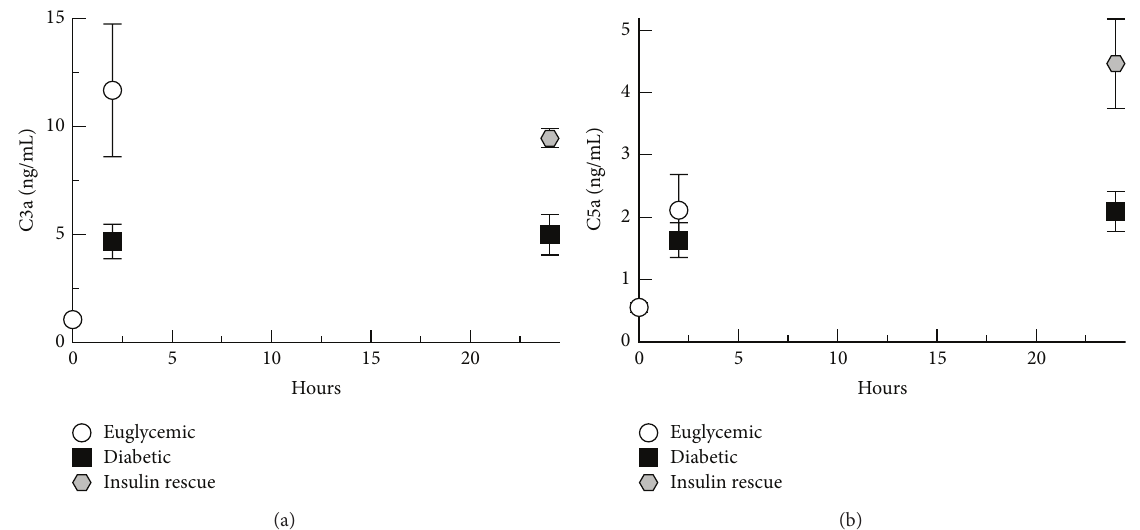
Figure 3: Anaphylatoxin generation in the peritoneum. (a) C3a concentrations in peritoneal wash fluid assayed by quantitative Western blot. (b) C5a concentrations in peritoneal wash fluid assayed by ELISA. Graphed data shows means of results for peritoneal samples from the animals in each treatment group. Error bars denote standard error of the